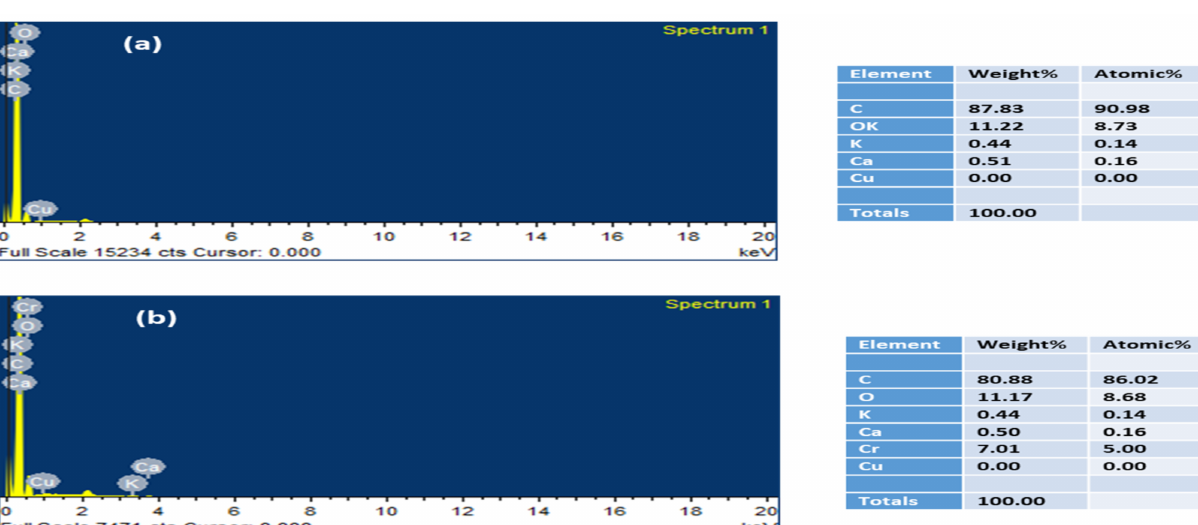
Figure 6. EDX data of chromium adsorption on the walnut shell biochar: ( a ) unloaded walnut shell and ( b ) chromium-loaded walnut